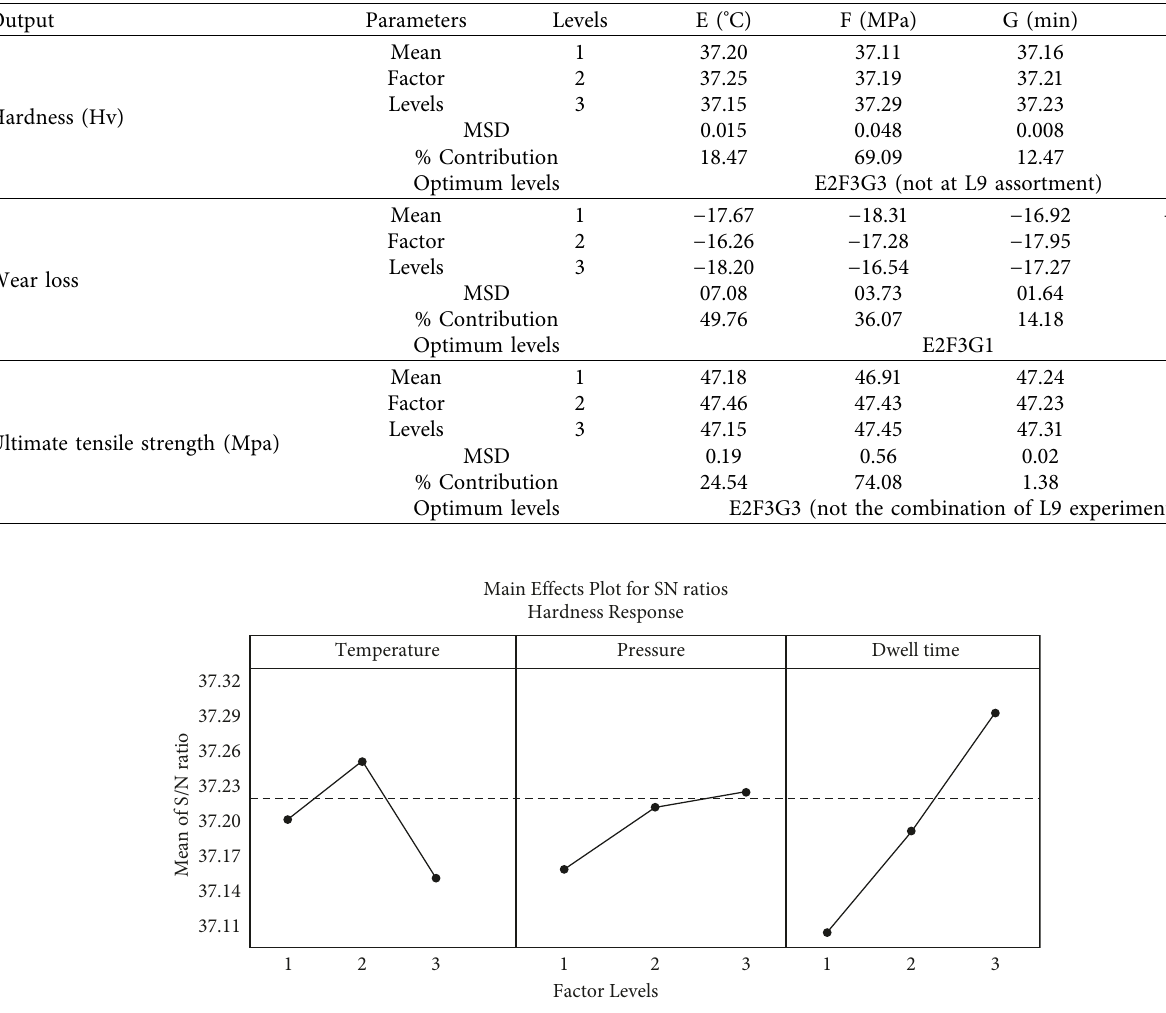
Table 8: Hot-pressing progression’s Pareto ANOVA results.